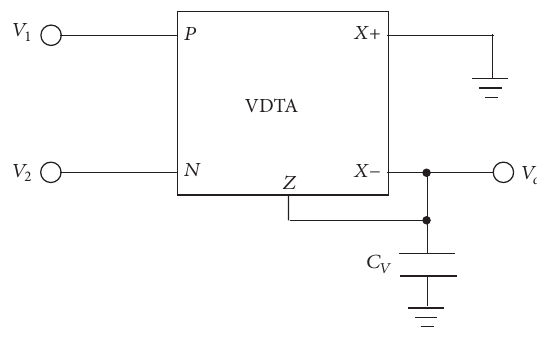
Figure 5: Lossy integrator using